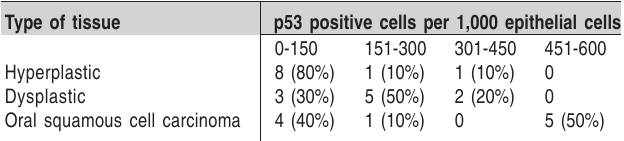
Table 1. Number and percentage of patients in each group in different class intervals of p53 positive cells.